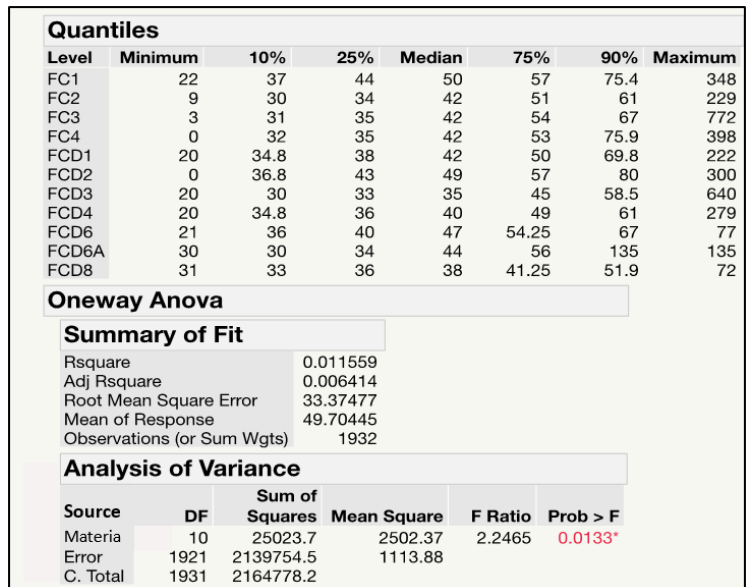
Figure 9. ANOVA of transportation time versus 11 materials. * indicates that the statistical test result is significant.